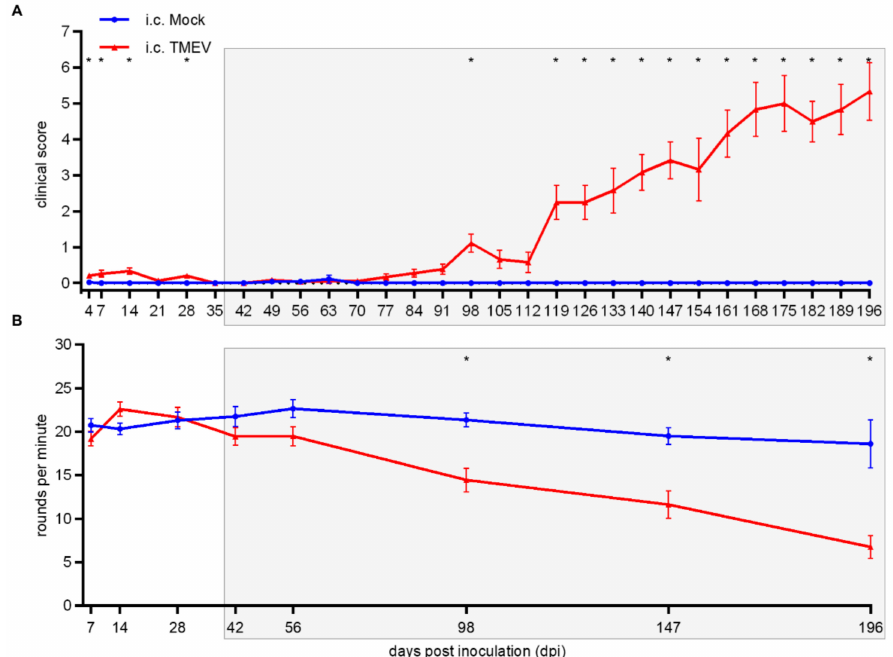
Figure 7. Clinical investigation and rotarod performance test of SJL mice following intracerebral (i.c.) TMEV infection / mock-injection. At 4, 7, 14, 28 and 98 dpi and 119–196 dpi, TMEV-infected animals showed significantly elevated clinical scores ( A ). Deterioration of motor coordination was detected starting at 98 dpi ( B ). Graphs display mean (solid line) and standard error of the mean (SEM). Significant di ff erences between the groups as detected by ANOVA followed by Mann–Whitney U posthoc tests are marked by asterisks (* p <